Question: Write a single sentence explaining what this figure depicts.
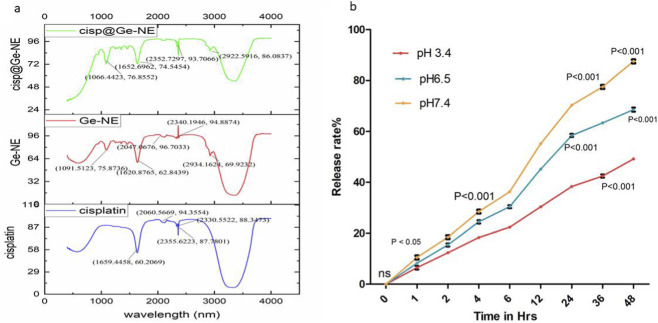
Answer: (a) FTIR spectral analysis of cisplatin, GE-NE, and Cisp-GE-NE. The FTIR spectrum of pure cisplatin shows characteristic peaks at 1,066, 1,455, 2060, 2,355, and 3,522 cm -1 , corresponding to amine, NH bending, and Pt–N bond vibrations. GE-NE displayed peaks at 820, 1,091, 1,234, 1,628, and 2,941 cm -1 , attributed to C–H stretching, OH bending, and ester/alkene groups. In the Cisp-GE-NE spectrum, the presence of both sets of peaks with slight shifts and reduced intensities confirms successful drug encapsulation and interaction, likely through hydrogen bonding or van der Waals forces. These spectral overlaps indicate the chemical compatibility and stable integration of cisplatin into the nanoemulsion system. (b) In vitro release kinetics of cisplatin from Cisp-GE-NE over 48 h at different pH levels (3.4, 6.5, and 7.4), measured as cumulative release percentage (%). The release rate significantly increased with higher pH: at 48 h, the release was 95.4% ± 2.1% at pH 7.4, 78.2% ± 1.9% at pH 6.5, and 52.6% ± 2.3% at pH 3.4. Statistical analysis using two-way ANOVA followed by the Bonferroni post hoc test revealed highly significant differences between the groups: P < 0.05 at 1 h, and P < 0.001 at all subsequent time points (2, 6, 12, 24, 36, and 48 h). The highest release at pH 7.4 suggests favorable drug diffusion in physiological pH, while reduced release at acidic pH implies pH-responsive control suitable for targeting the tumor microenvironment.